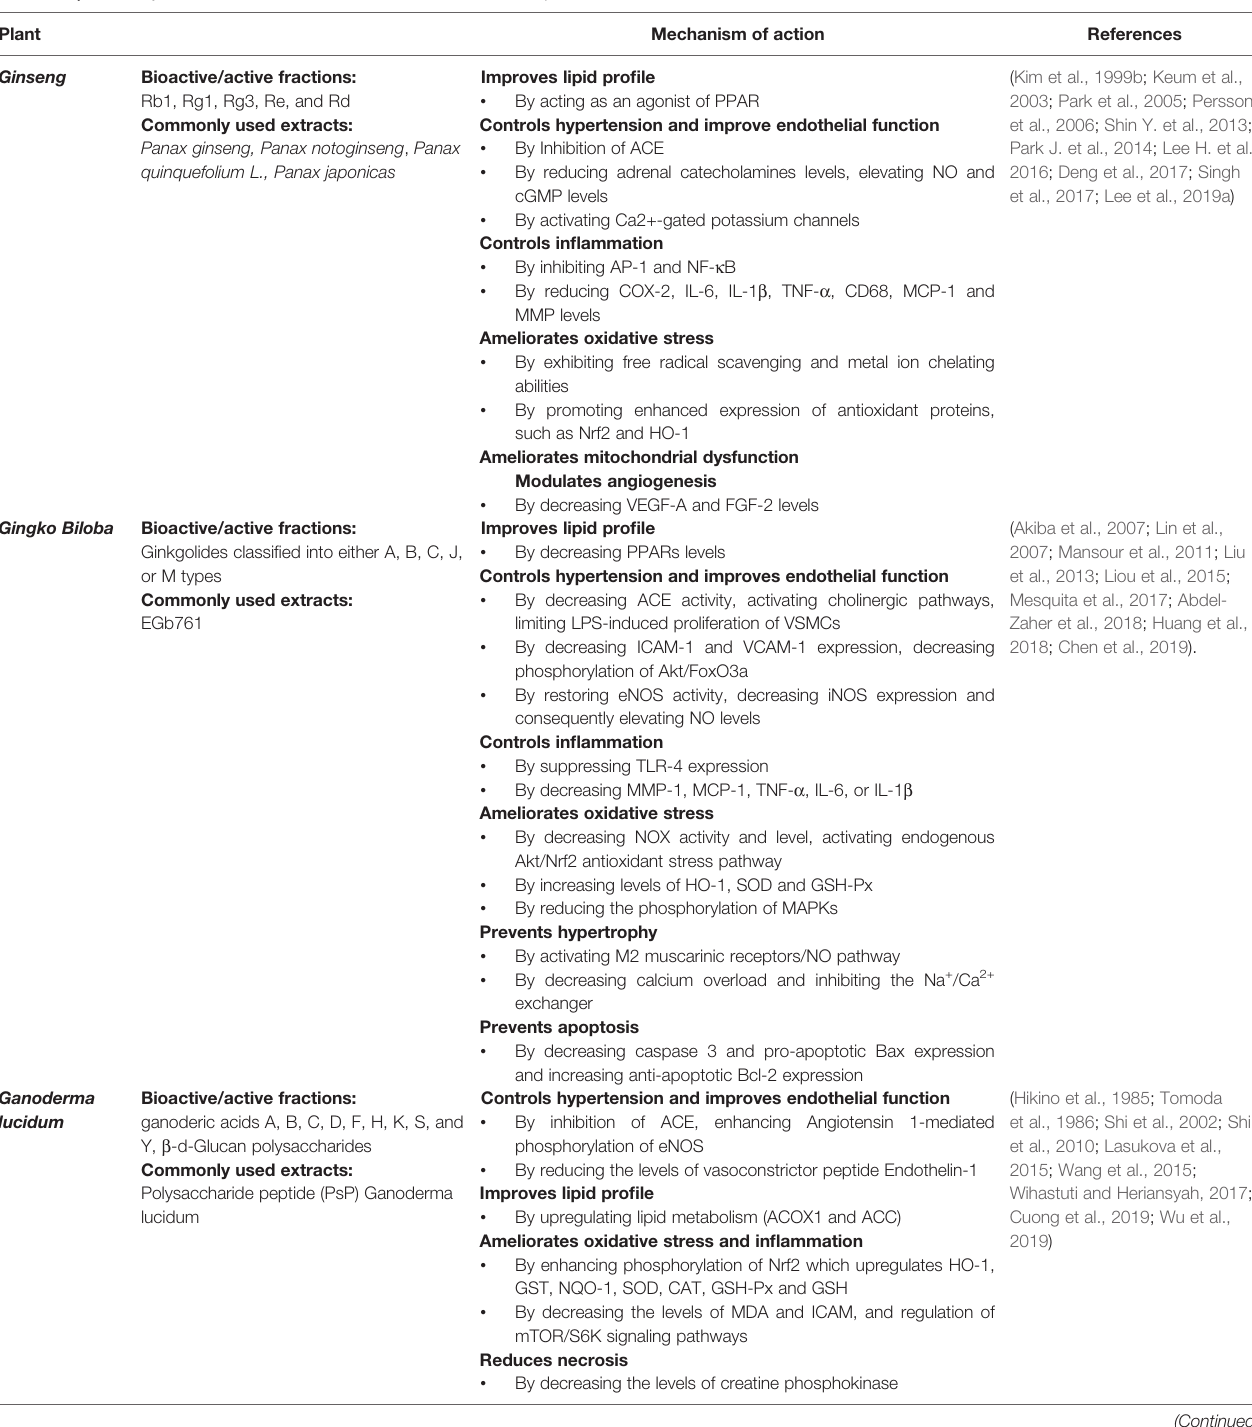
TABLE 2 | Summary of the mechanisms of action of the four discussed